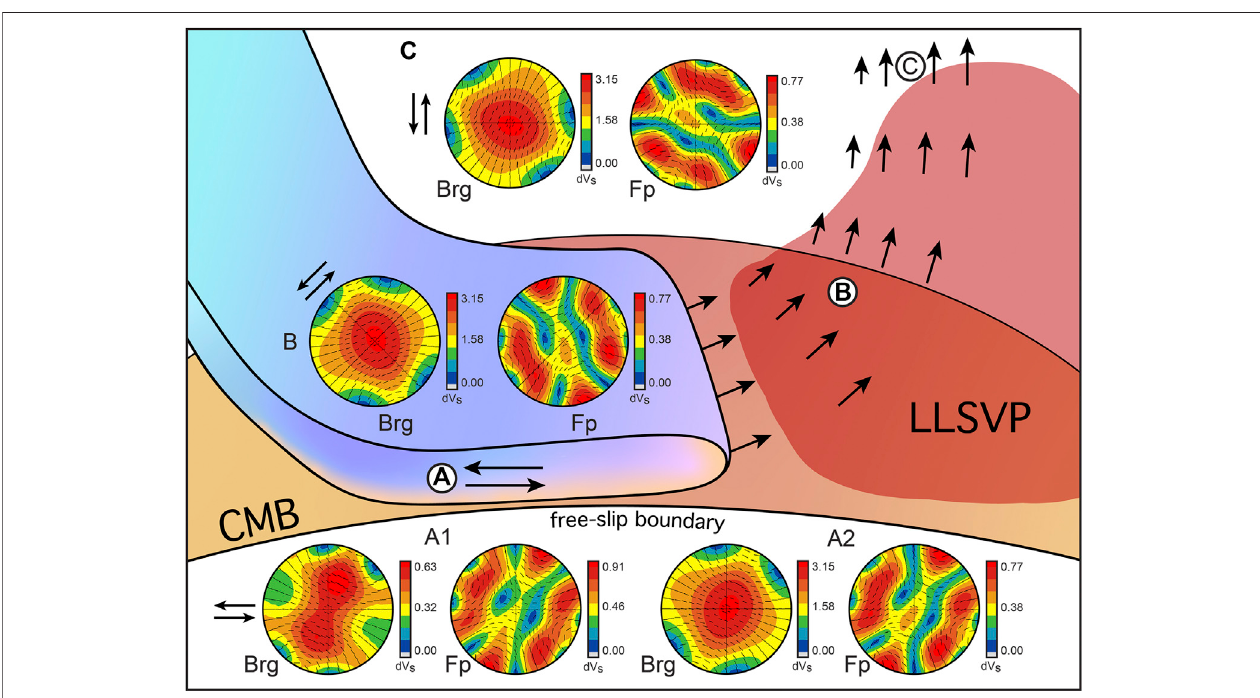
FIGURE 13 | Schematic diagram of shear wave splitting associated with a subducting slab in the D ” region. The slab is shown subducting along the core-mantle boundary (CMB). Large arrows show mantle fl ow around the edge of a large low-shear-velocity province (LLSVP). The schematic shows three possible locations of seismic anisotropy indicated by circled, capital letters: (A) deformation within the slab; (B) mantle fl ow at an angle to the CMB; (C) regions of upwelling. Uncircled letters refertotheseregionsandareadjacenttoplotsofpercentshearwavesplitting( δ V S )madeforahypotheticalmantle “ rock ” composedof80%bridgmanite and20% ferropericlase at 100% strain. Plots labeled Brg show a case where bridgmanite textures and ferropericlase is randomly oriented. Plots labeled Fp show a case where ferropericlase textures and bridgmanite is randomly oriented. Arrows adjacent to plots indicate the sense of shear. In order to represent possible P/T variation in a subducting slab, region (A) includes CMB conditions (A1, 136 GPa and 4000 K) and a possible pressure/temperature condition at the top of the D ” (A2, 126 GPa and 2,800 K/3,000 K). A pressure and temperature condition of 126 GPa and 2,800 K/3,000 K was used for shear-wave splitting plots (B) and (C) . The black lines in the stereo plots are the orientation of displacement for the fast shear velocity (V S1 , see